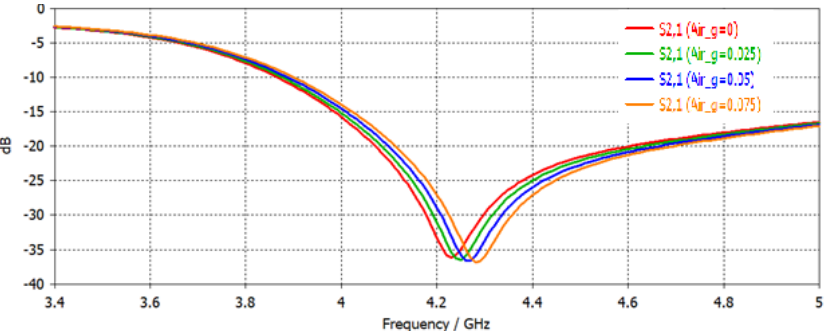
Figure 8. Analysis of air gap effect on the resonance frequency.